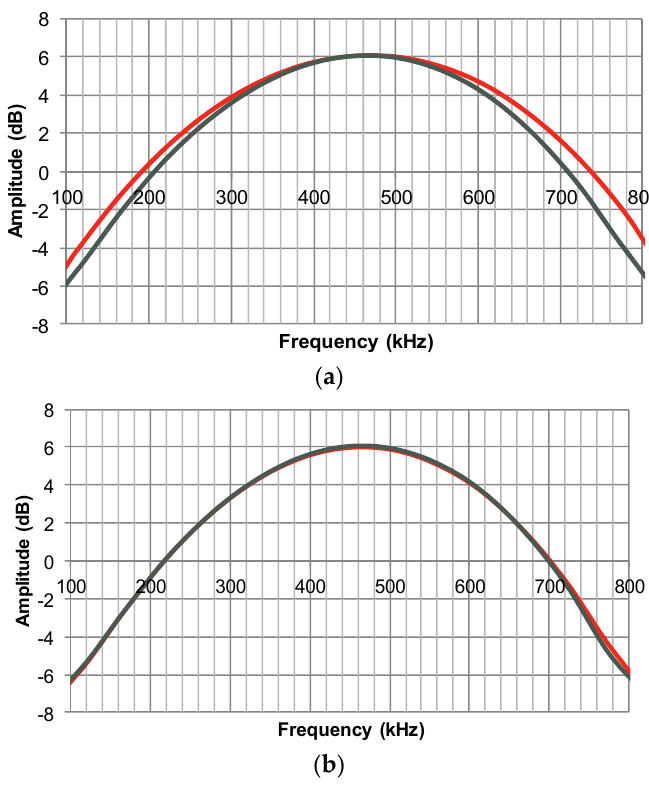
Figure 3. Normalised Fourier transforms of pulse ‐ echo response of transducers. The − 6 dB bandwidths can be found from the intersections with the 0 dB line. ( a ) Two dry piezoceramic elements; ( b ) Two oil ‐ saturated transducers.